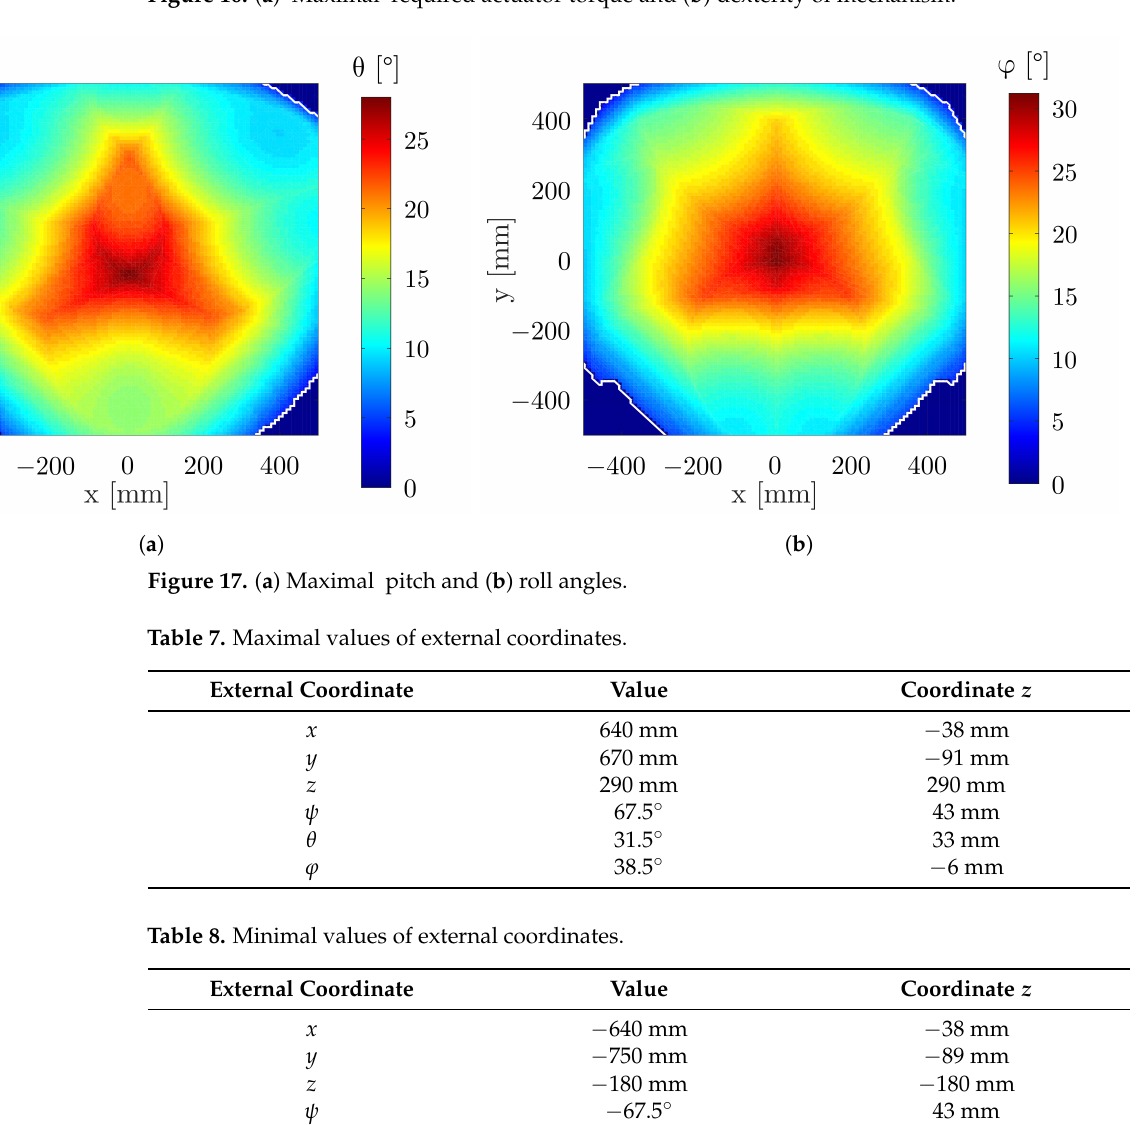
Figure 16. ( a ) Maximal required actuator torque and ( b ) dexterity of mechanism.